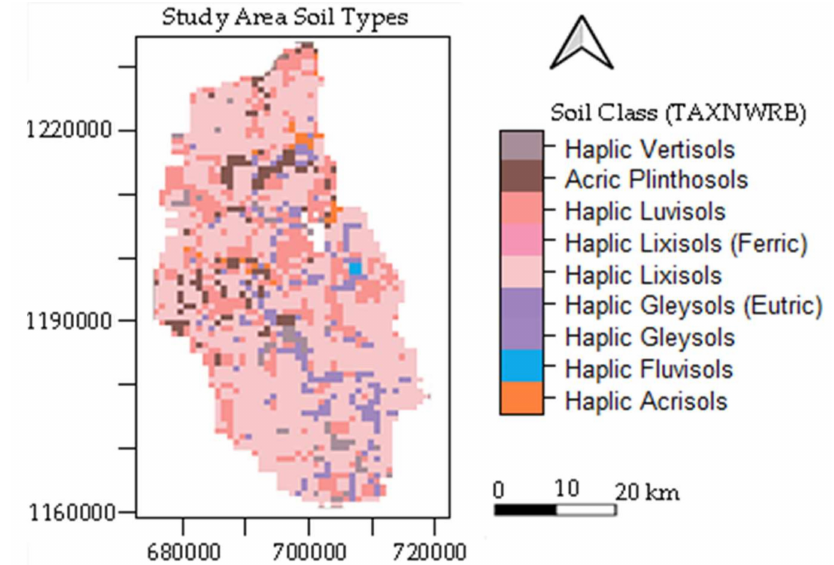
Figure 2. Map of soil classification of the study area (Source: ISRIC World Soil Information, 2017 available at https: // soilgrids.org /